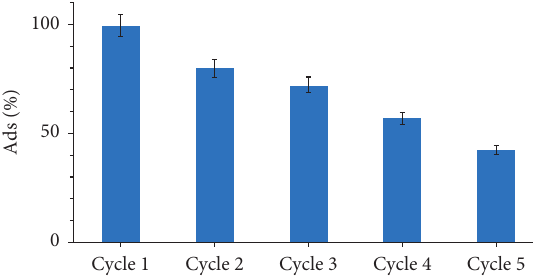
Figure 8: Regeneration cycles of the activated carbon.